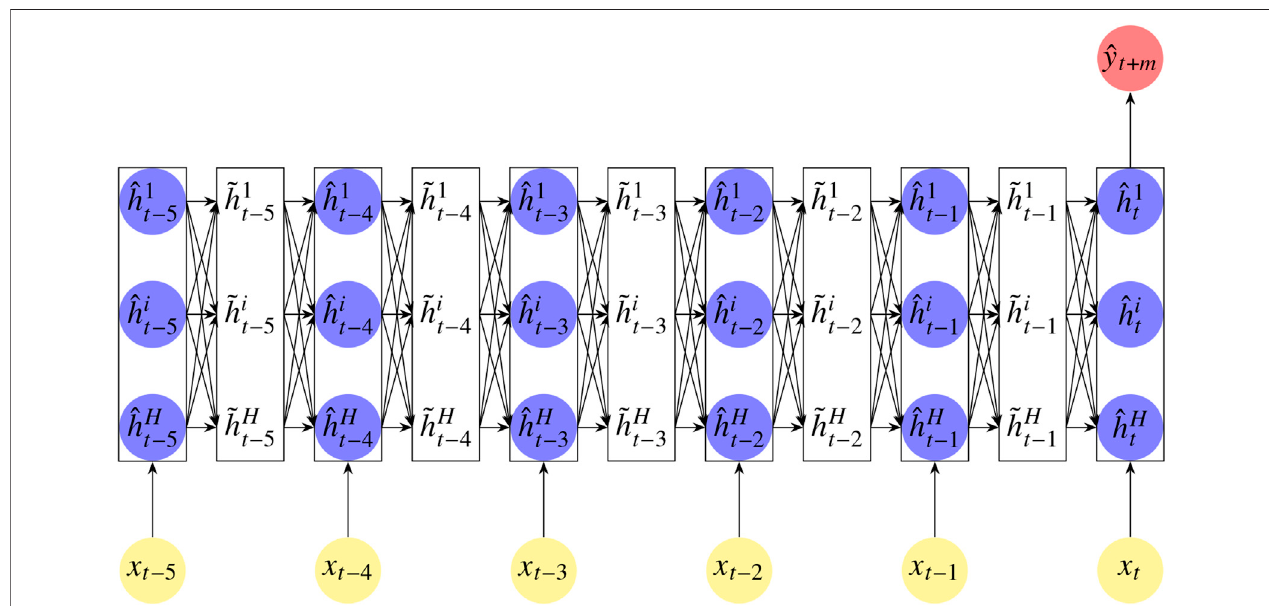
FIGURE 1 | An illustrative example of an α -RNN with an alternating hidden recurrent layer (with blue nodes) and a smoothing layer (white block), “ unfolded ” over a sequence ofsix time steps. Each lagged feature x t − i in the sequence x _ t isdenoted by theyellownodes. The hidden recurrent layer contains Hunits (bluenodes)and the i th output, after smoothing, at time step t is denoted by ~ h i t . At the last time step t, the hidden units connect to a single unactivated output unit to give (cid:1) y t + m (red